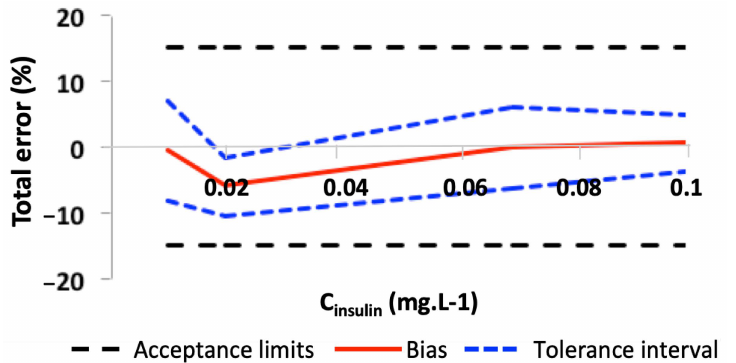
Figure 3. Accuracy profile for the LC-MS/MS R-insulin assay. The black dashed lines correspond to the ± 15% acceptance limits, the red line corresponds to the bias, and the dashed blue lines correspond to the bias’s tolerance interval for a beta risk of